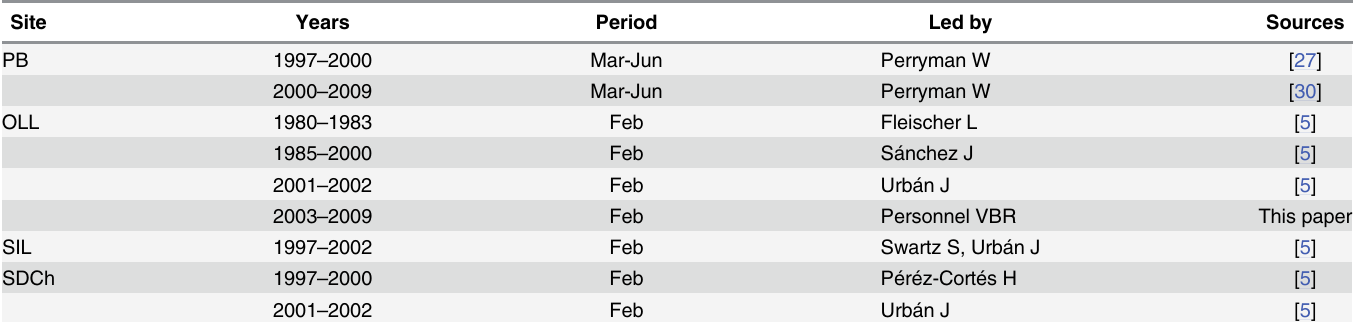
Table 1. Sources of mother-calf pairs data. Site: site where the survey was done (from north to south): Piedras blancas (PB), Ojo de Liebre Lagoon (OLL), San Ignacio Lagoon (SIL), Santo Domingo Channel (SDCh) north of Bahia Magdalena; year: years when the surveys were done; period: months of the year when the surveys were done; led by: person who led the surveys, VRB: El Vizcaino Biosphere Reserve; Source: reference where the data was taken.